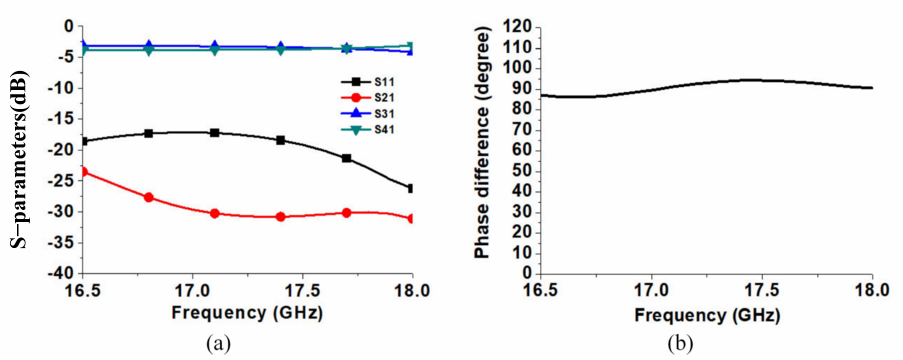
Figure 5. ( a ) Simulated S–parameters of the 3 dB SIW coupler and ( b ) simulated phase difference between two output ports of the 3 dB SIW coupler.